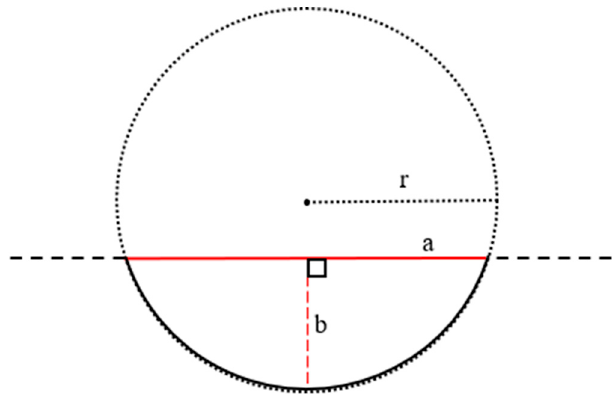
Scheme 1. Circular method: printed 3D models are represented as an